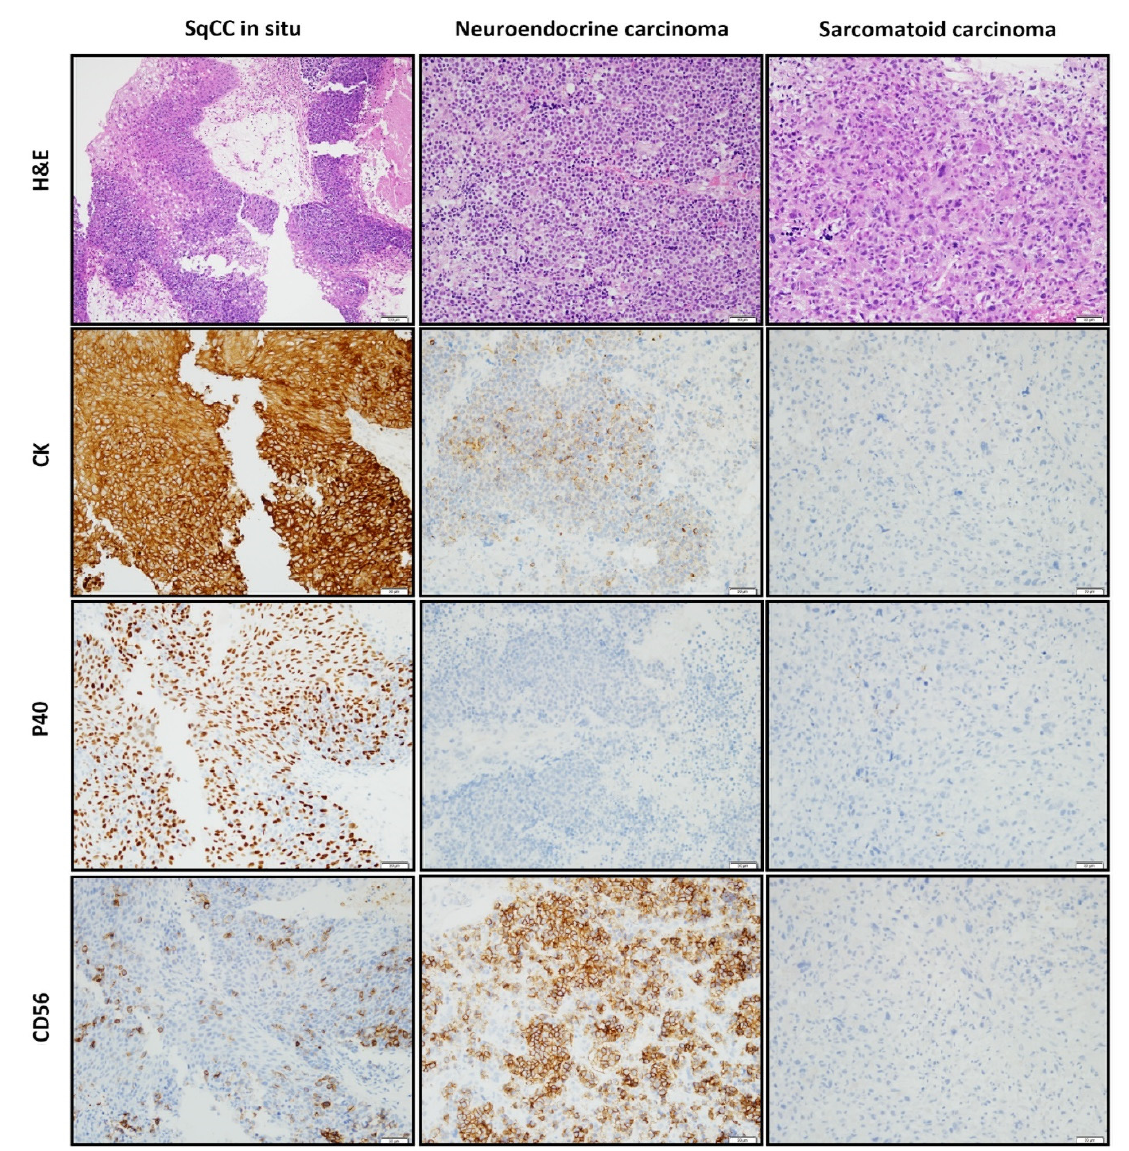
Figure 3. To characterize each component, an immunohistochemical examination was performed. The results of the immunohistochemical studies are illustrated in Figure 3. ( Left column ) The three components clearly showed differences in their immunoprofiles. SqCCis was diffusely cytoplasmic positive for pan-cytokeratin (CK) and nuclear positive for P40, but negative for the neuroendocrine markers CD56, synaptophysin, and chromogranin. Conversely, the nests of atypical small cells were positive for CK with a perinuclear dot pattern and diffusely cytoplasmic positive for the neuroendocrine markers CD56, synaptophysin, and chromogranin. ( Middle column ) However, the nests were negative for P40. ( Right column ) The anaplastic spindle cell lesion was negative for all markers. Based on the histologic features and the results of the immunohistochemical studies, a diagnosis of combined SNEC and sarcomatoid carcinoma arising in an inverted papilloma was rendered. It is important to distinguish whether a spindle cell lesion is another sarcoma or a spindle cell variant of SqCC (sarcomatoid carcinoma). A diagnosis of sarcomatoid carcinoma can be considered if the existing conventional squamous cell carcinoma is mixed with the spindle cell lesion or if the SqCCis is present together [8,9]. In our case, because the spindle cell component coexisted with SqCCis, we diagnosed this component as sarcomatoid carcinoma rather than another sarcoma. The original magnifications were 200×.